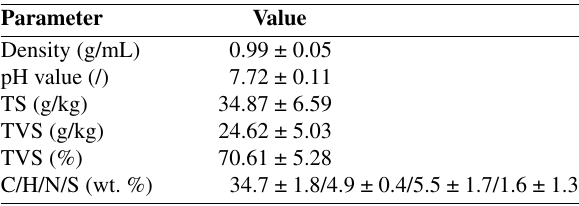
Table 1. Characteristics of anaerobic sludge used as